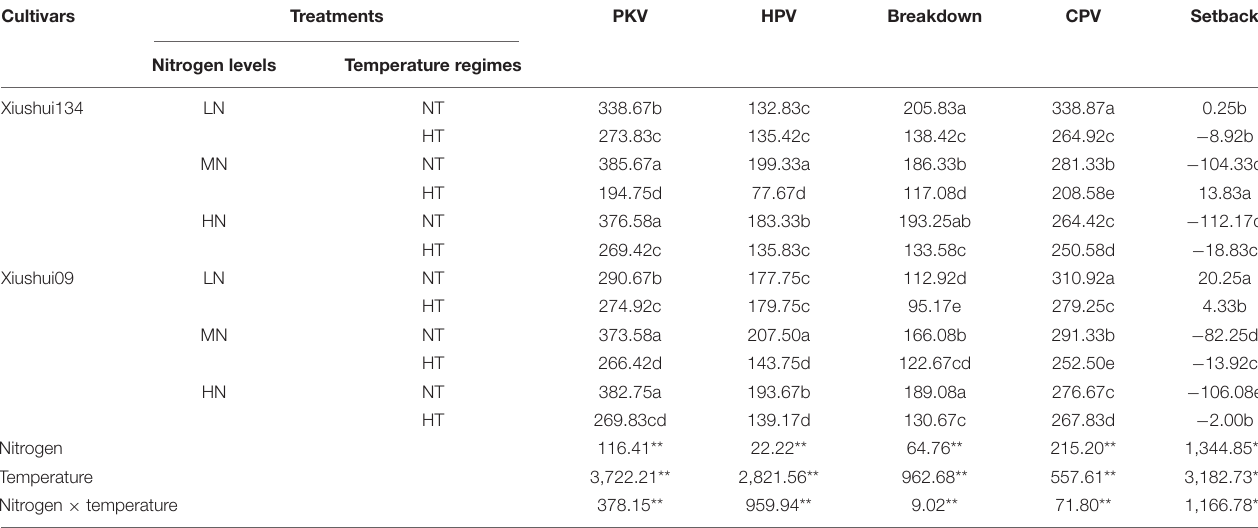
TABLE 5 | Difference in RVA parameters among different treatments (RVU).